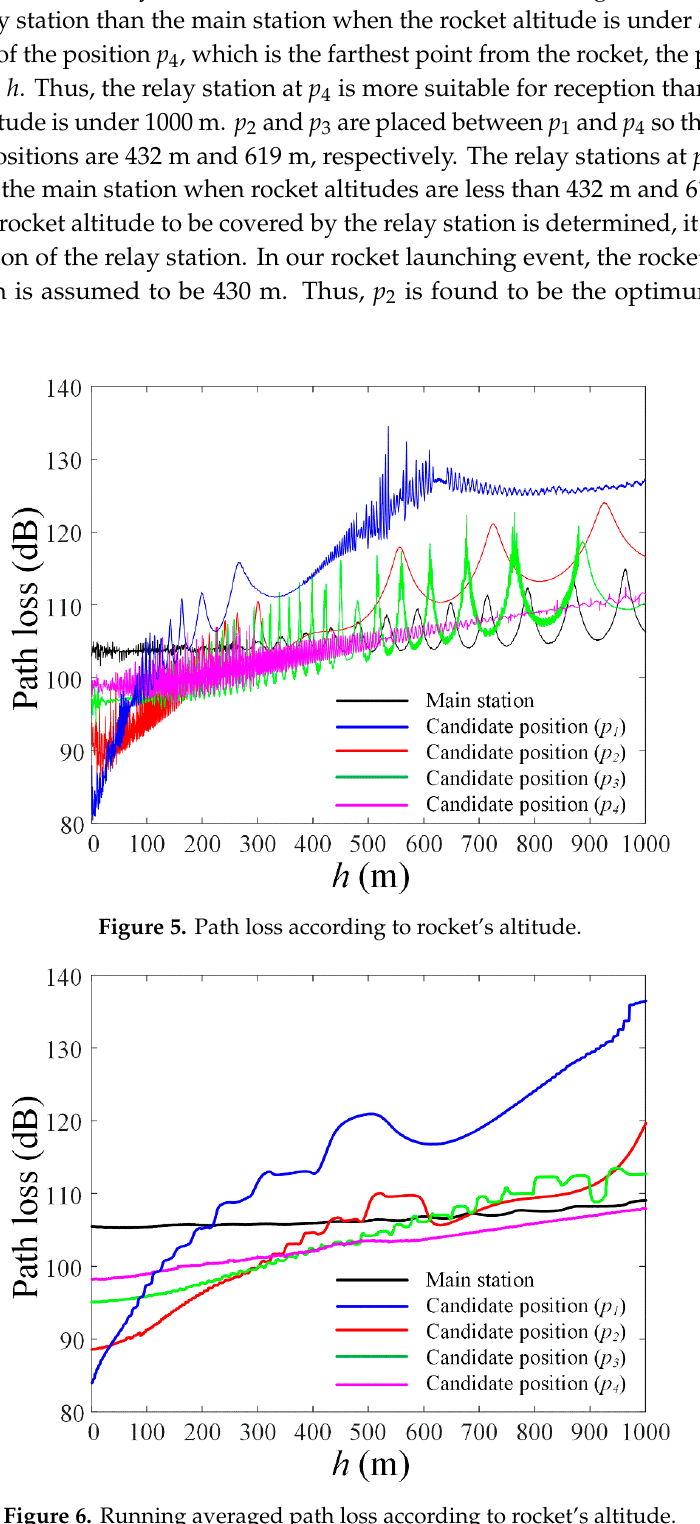
Figure 6. Running averaged path loss according to rocket’s altitude.